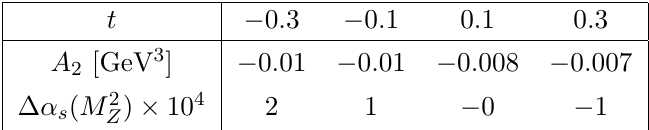
Table 9 . Values of A 2 and variation of (cid:11) s ( M 2 is